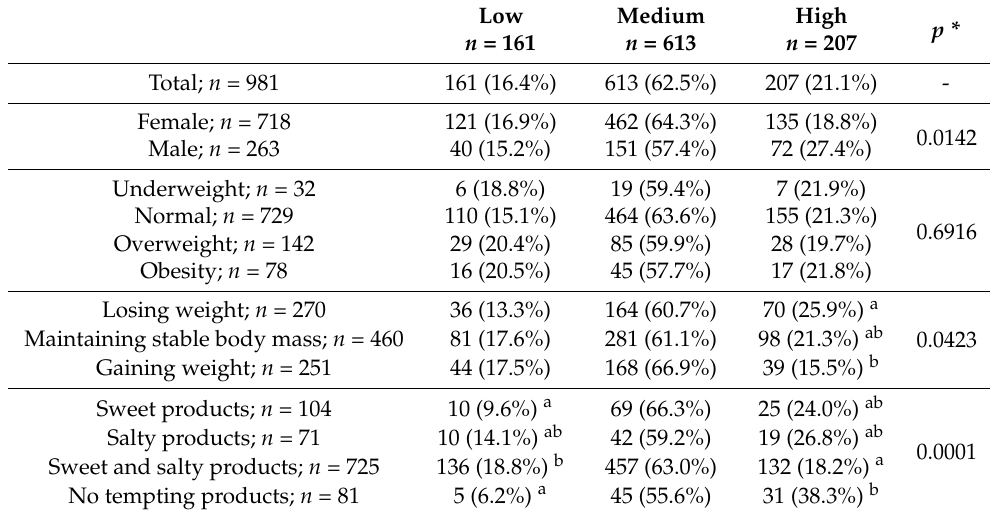
Table 7. The self-regulation of eating-behavior categories assessed using the Self-Regulation of Eating Behaviour Questionnaire (SREBQ), within the Polish Adolescents’ COVID-19 Experience (PLACE-19) Study ( n = 981) and in